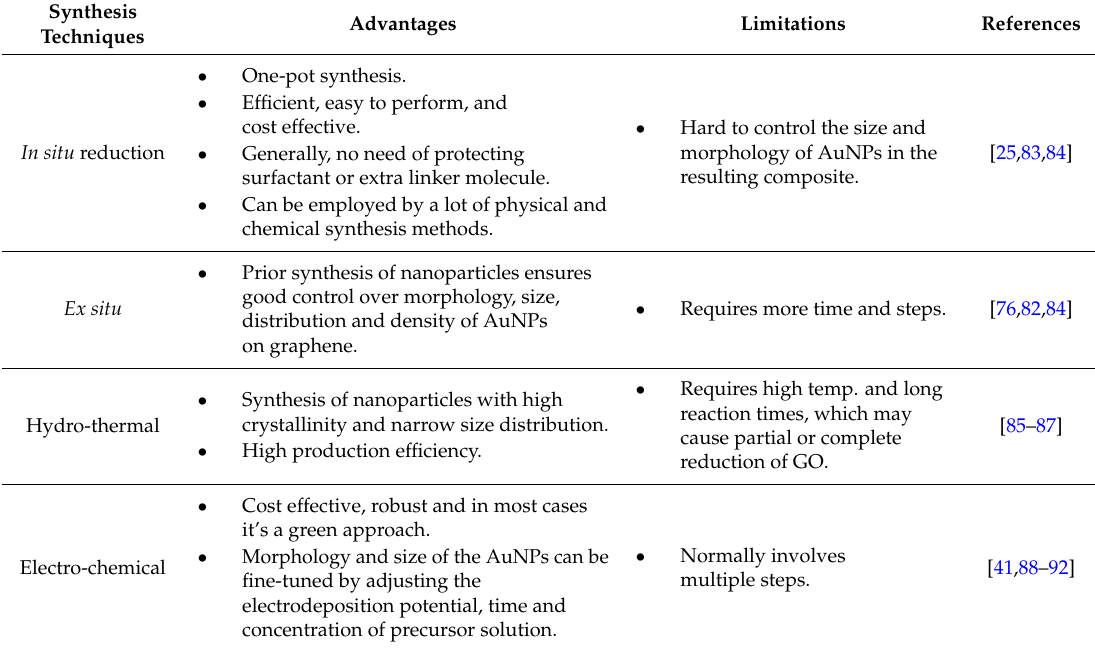
Table 3. Advantages and limitations of the major synthesis techniques of graphene–gold nanocomposites. Synthesis